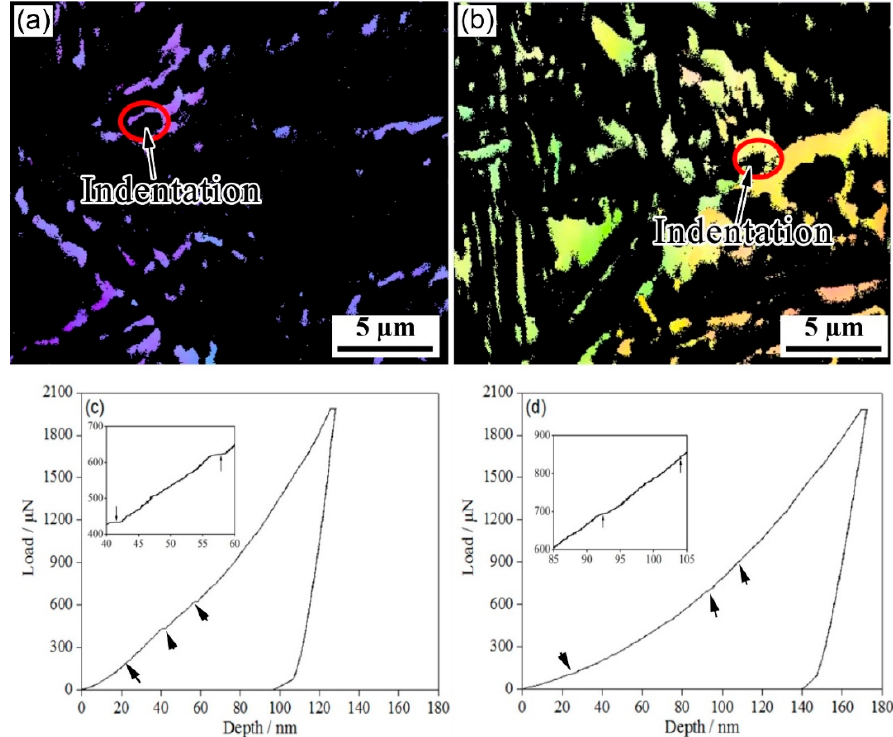
Figure 6. Nanoindentation of blocky retained austenite in the investigated steel for ( a , c ) one-step and ( b , d ) two-step techniques. ( a , b ) FCC structures and ( c , d ) representative load–displacement plots.